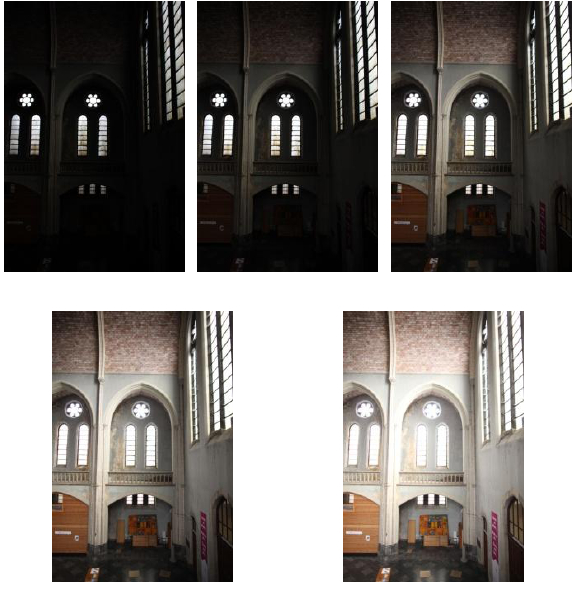
Figure 6: Bracketed exposure sequence of the scene from -